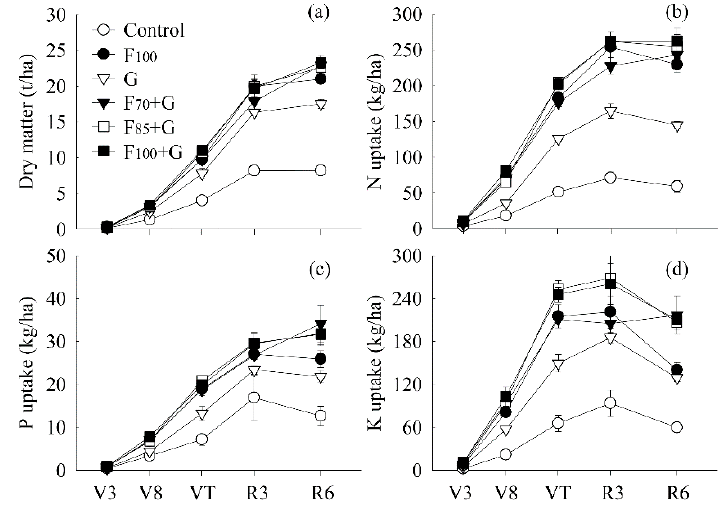
Figure 3. ( a ) Dry matter accumulation, ( b ) nitrogen (N) uptake, ( c ) phosphorus (P) uptake, and ( d ) potassium (K) uptake along maize development stages in 2012. Vertical bars indicate standard error of means ( n = 4). V3 and V8 (the third and eighth leaf fully expanded, respectively), VT (tasseling), R3 (milk), and R6 (physiological maturity). Control, no fertilization; F 100 , recommended inorganic fertilization alone; G, green manure incorporation alone; F 70 + G, F 85 + G, and F 100 + G are 70%, 85%, and 100% of F 100 plus G, respectively.